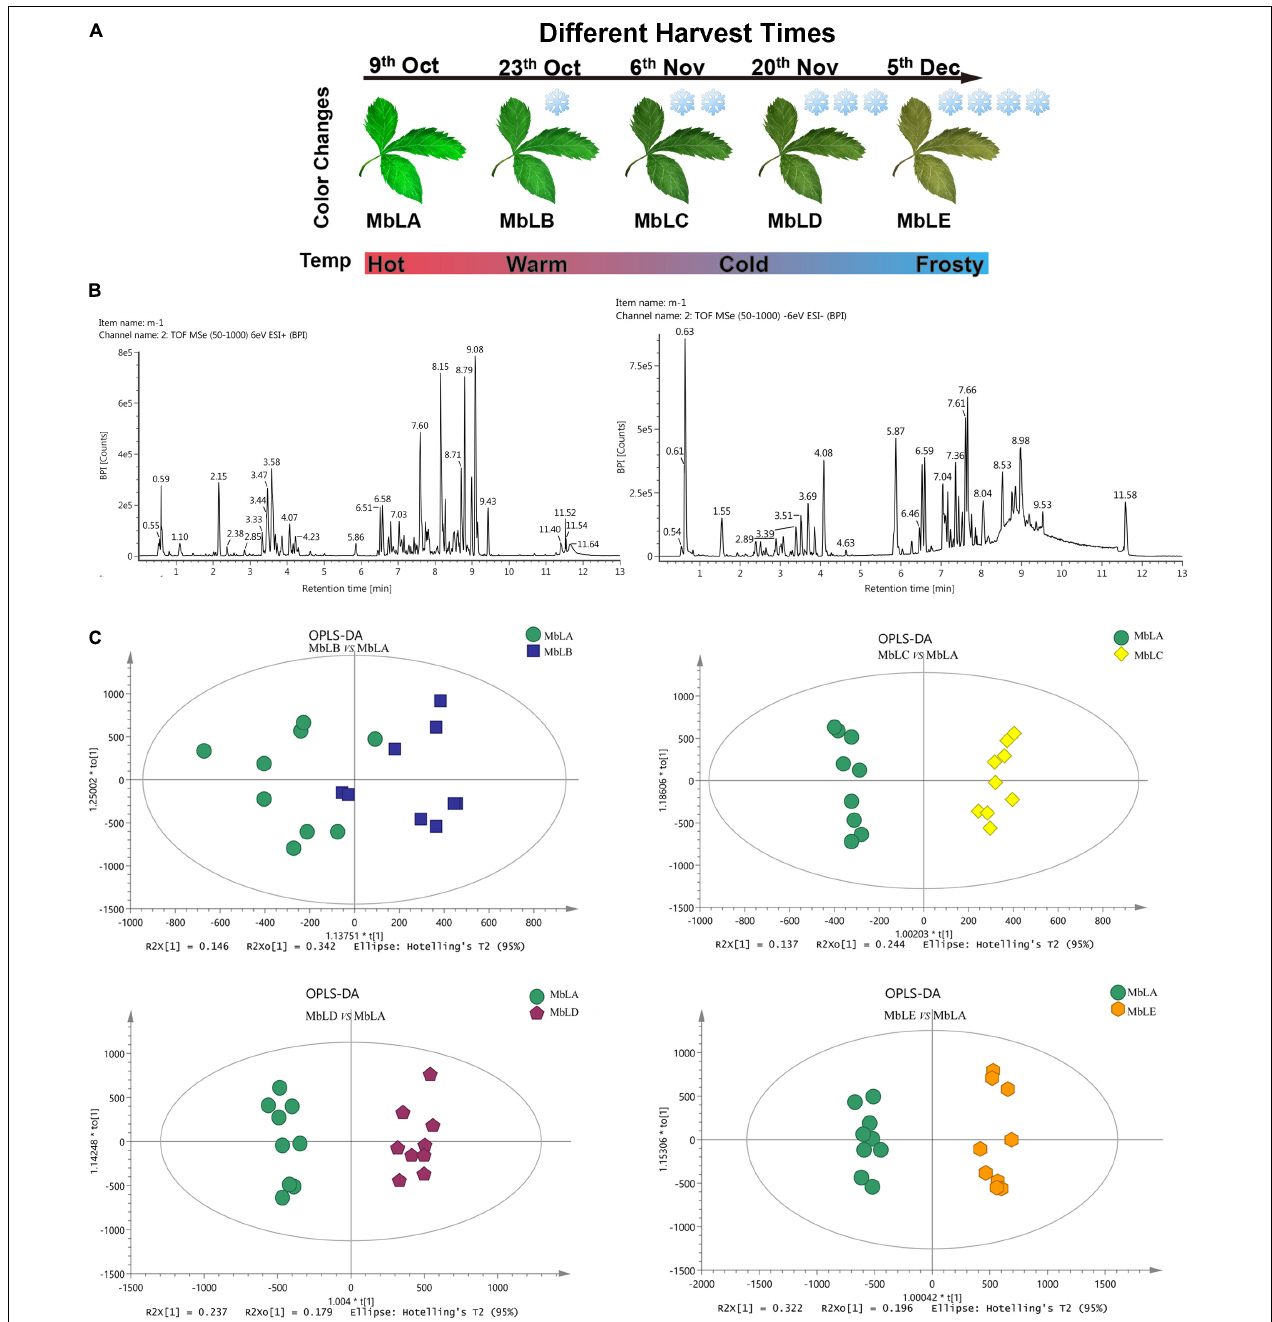
FIGURE 1 | Metabolite accumulation in the mulberry leaves at five periods. (A) Mulberry leaves picked on October 6th were recorded as MbLA group; those picked on October 23th were recorded as MbLB group; those picked on November 6th were recorded as MbLC group; those picked on November 20th as MbLD group, and those picked on December 5th were recorded as MbLE group. (B) Analysis of compounds extracted from the sample of mulberry leaves using UPLC-Q-TOF/MS. Base peak intensity (BPI) chromatogram of extract analyzed by UPLC-Q-TOF-MS in positive and negative ion mode. (C) Score plots for OPLS-DA analysis based on UPLC-Q-TOF-MS data of mulberry leaves extracts obtained from the MbLB to MbLE, with MbLA as the control group. Each point represents an independent biological replicate, and each ellipse represents the 95%